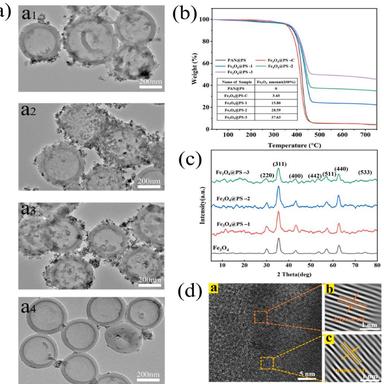
(a) TEM images of the Fe3O4@PS hollow spheres with different amounts of Fe3O4 (1–3) and Fe3O4@PS–C (4), (b) TGA curves of Fe3O4@PS and Fe3O4@PS–C hollow spheres, (c) XRD images of Fe3O4@PS hollow spheres and Fe3O4 nanoparticles. (d) HRTEM images of Fe3O4@PS hollow spheres.